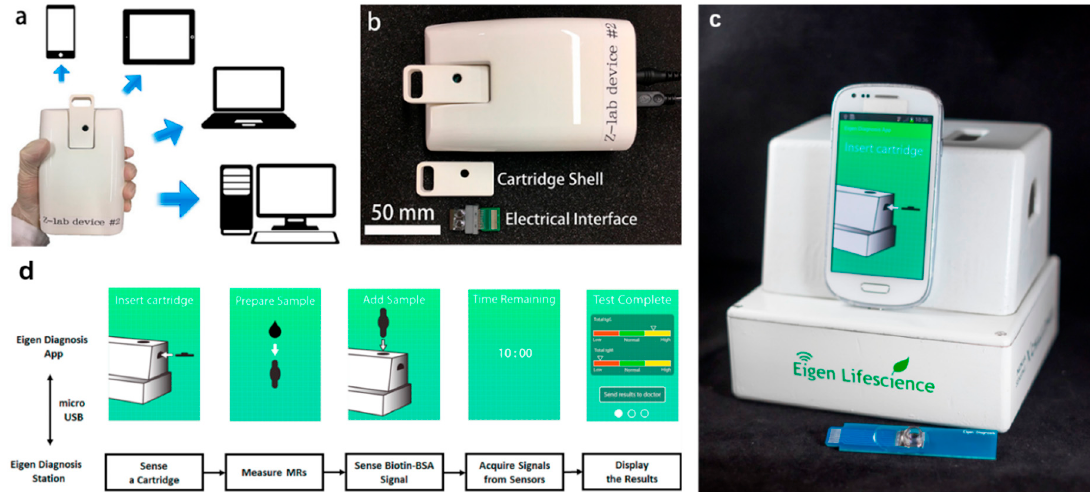
Figure 9. ( a ) The GMR handheld system can communicate with cell phones, laptops, tablets, and computers from Ref. [64]; ( b ) layout of the handheld system with the cartridge shell and electrical interface in Ref. [64]; ( c ) the Eigen Diagnosis Platforms (EDP) system from Ref. [20]; ( d ) the block diagram of the test process of the EDP system in Ref. [20]. The straightforward interface and process can lead users through the testing process and the results can be shown 10 min after the sample addition. Reprinted with permission from American Chemical Society 2017.